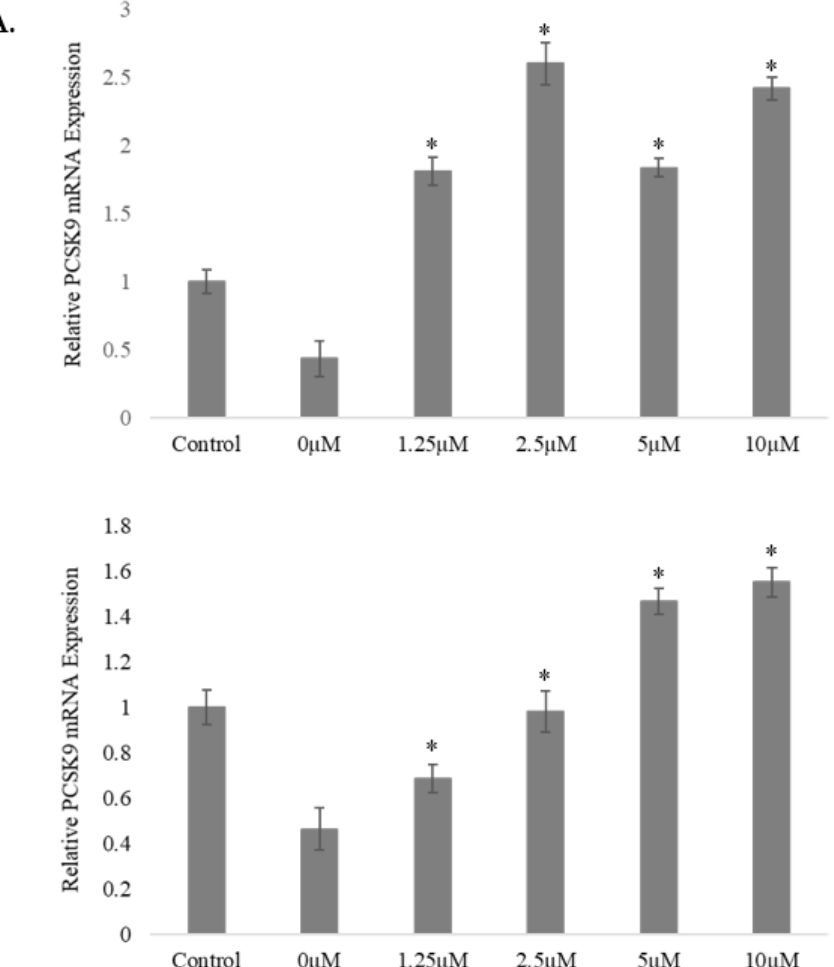
Figure 10. Effects of pre-treatment with MEK inhibitor (PD98059) ( A ) and PKC α inhibitor (HA- dihydrochloride) ( B ) on PCSK9 mRNA level in HepG2 cells treated with A. planci . Assigning the signal for the PCSK9/ β -actin ratio in the untreated cells as 1, the expression level of PCSK9 for each dose–response treatment is relative to this control value. Each value shows mean ± SEM of triplicate. * Indicates that the value at a particular time point was significantly higher than that for HepG2 cells treated with the selected A. planci fraction in the absence of inhibitor pre-treatment.